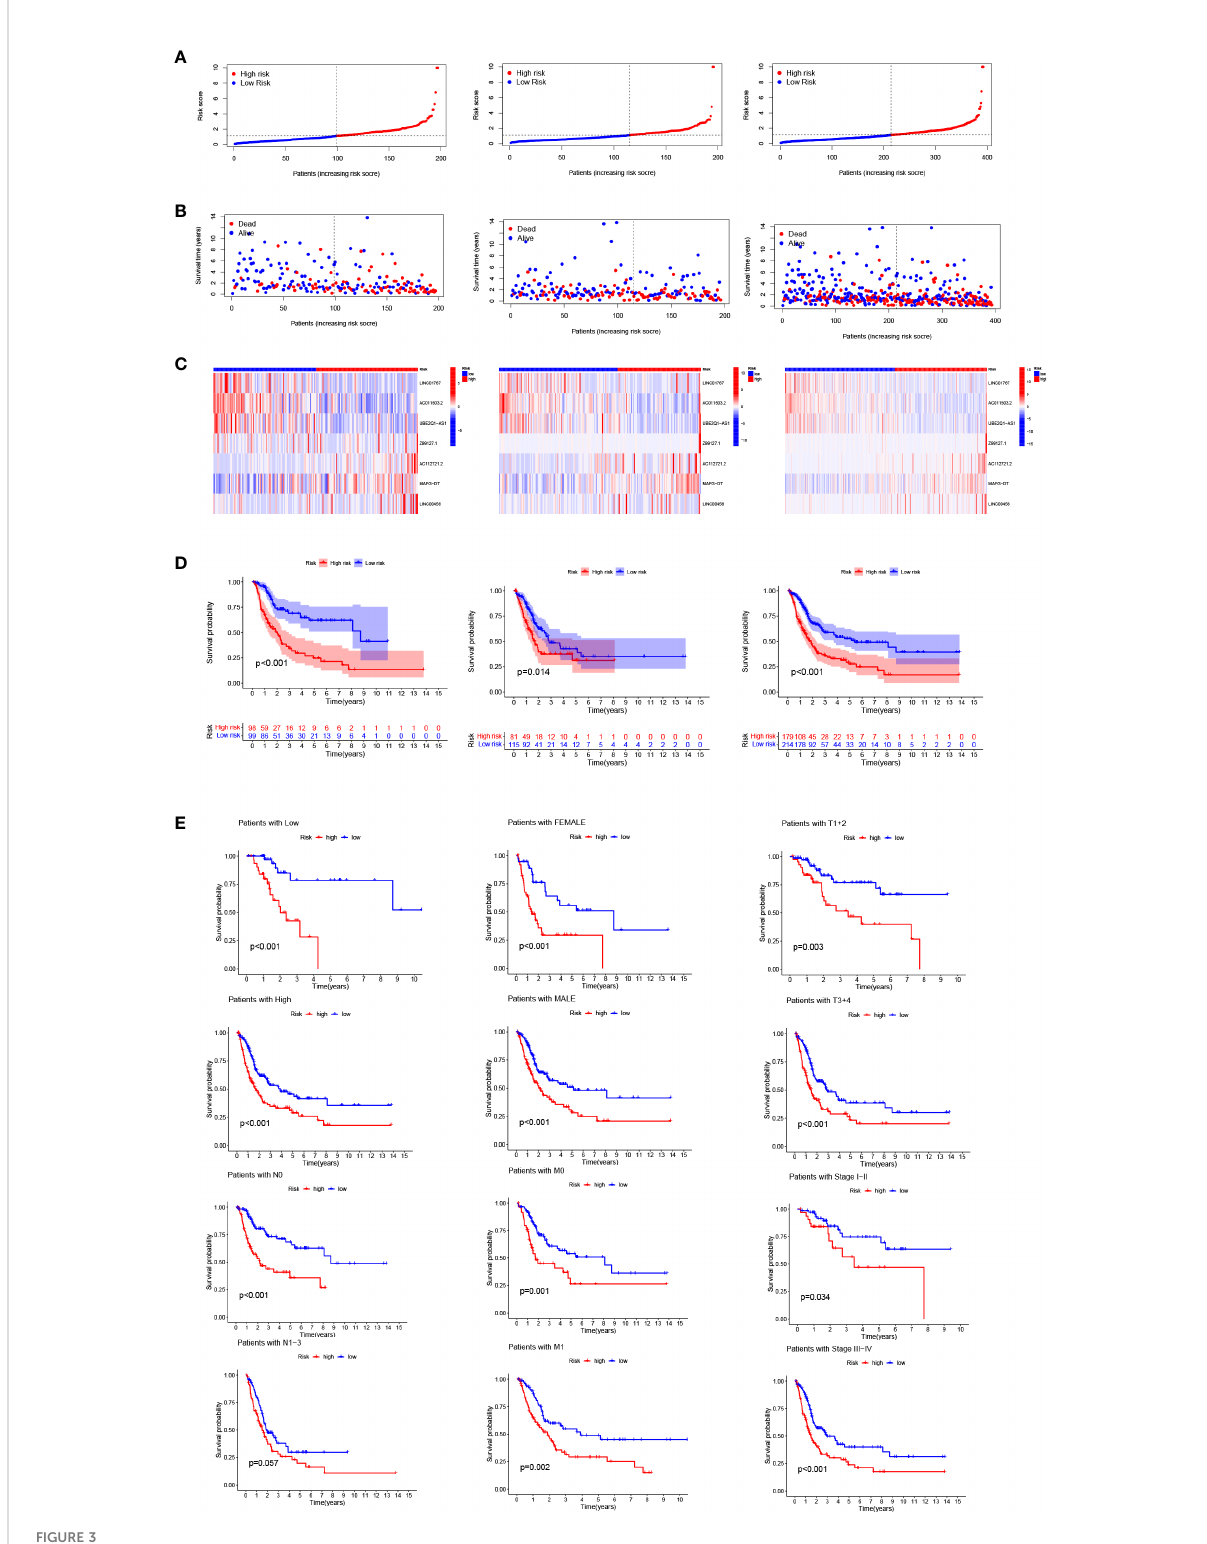
FIGURE 3 Risk model prognosis in the train, test and entire sets: (A) Risk score distribution diagram of train, test and entire sets; (B) Heat map of seven prognosis-related arlncRNAs; (C) The heat map of 7 lncRNAs expression in the train, test, and entire sets, respectively. (D) Survival analysis of high- and low-risk patients in train, test, and entire sets; (E) Survival analysis of clinicopathologic characteristics of high- and low-risk patients in entire